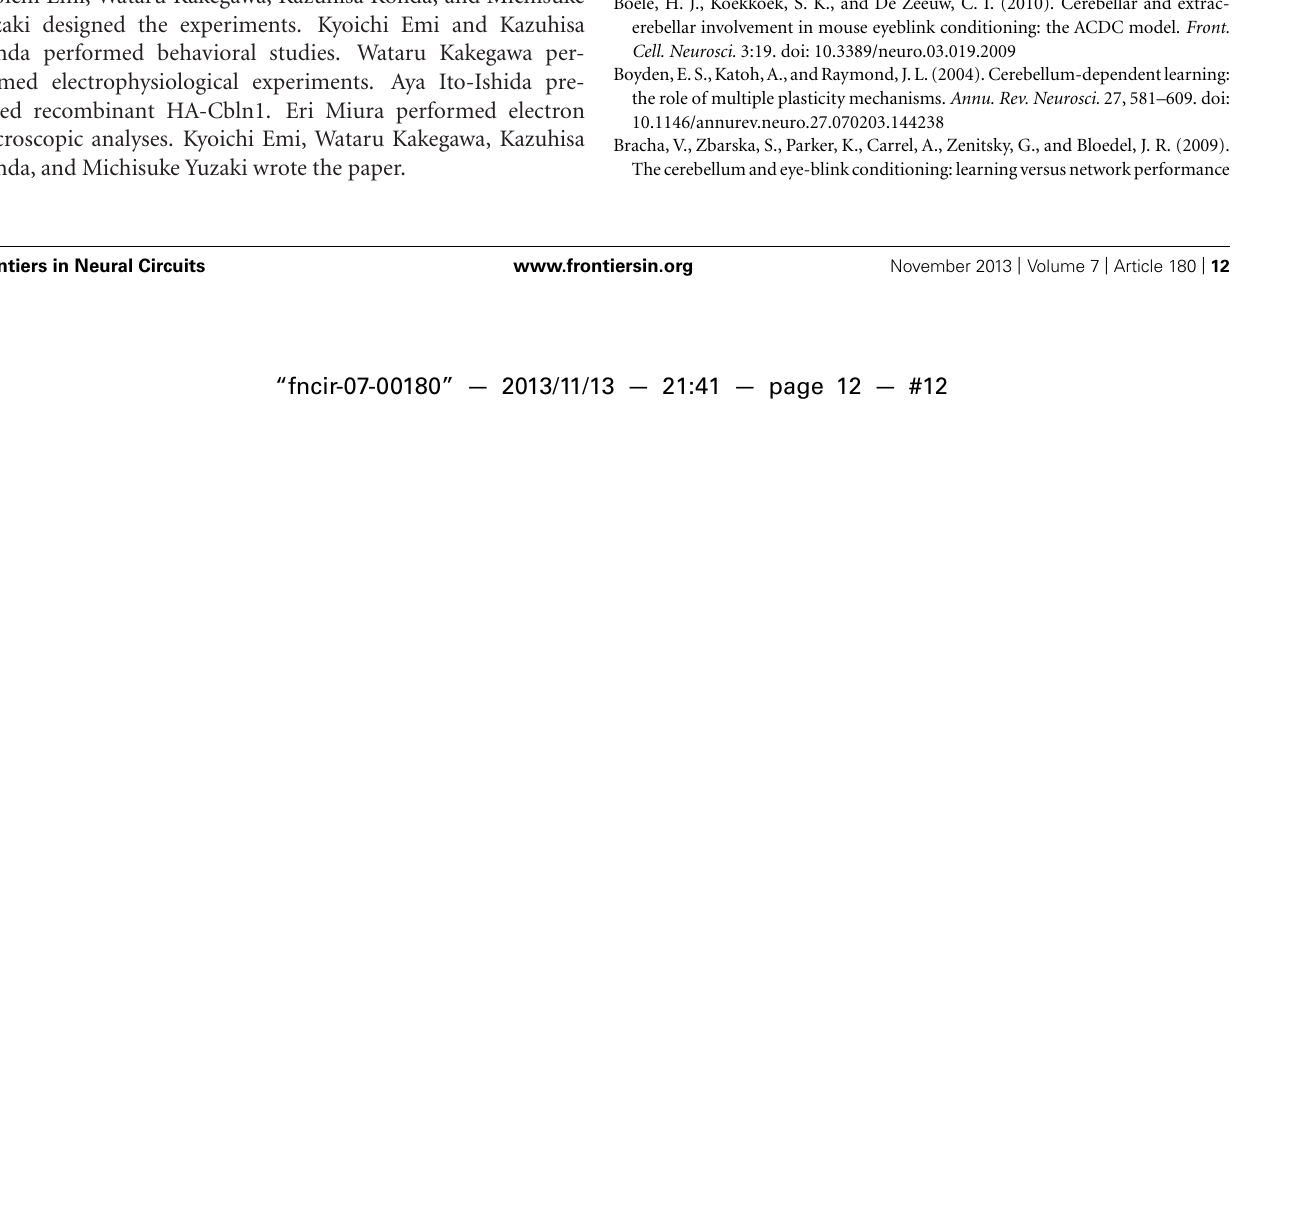
FIGURE 8 | Conditioned eyeblink responses (CRs) are extinguished in cbln1 − / − mice. (A) A diagram showing a sequence of experiments: cbln1 − / − mice were injected with Cbln1 as described in Figure 3 and trained for delay EBC (T1–T7) beginning 2 days after the Cbln1 injection. From day 40 (30 days after T7), mice were given extinction sessions (E1–E4), in which only a CS tone was given, 100 times per day, to examine the extinction of learned responses. (B) Intact extinction of conditioned eyeblink responses in cbln1 − / − mice. The CR% dramatically decreased in